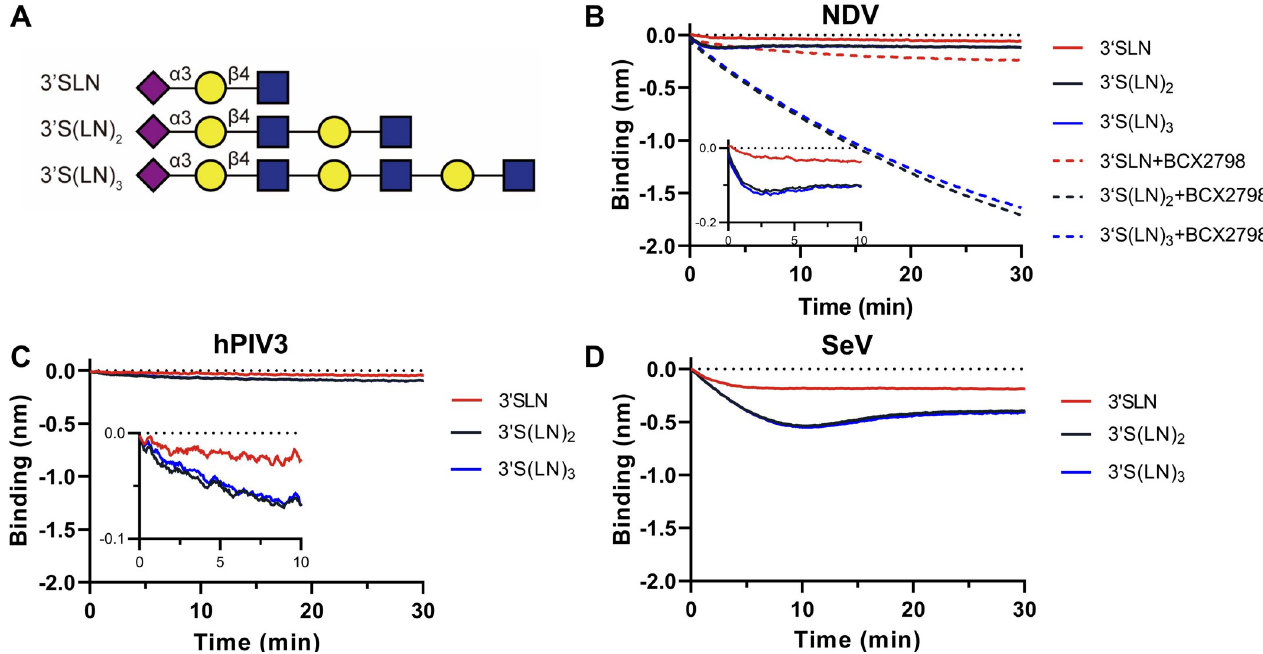
Fig 5. NDV, hPIV3, and SeV interaction with 3’SLN, 3’S(LN) 2 , or 3’S(LN) 3 . ( A) Schematic representation of biotinylated 3’SLN, 3’S(LN) 2 ,and 3’S(LN) 3 glycan structure. ( B) Analysis of NDV’s ability to bind to 3’SLN, 3’S(LN) 2 , or 3’S(LN) 3 in the presence or absence of BCX2798. Analysis of the ability of hPIV3 ( C ) and SeV ( D ) binding ability to 3’SLN, 3’S(LN) 2 , or 3’S(LN) 3 . Virus binding curves were generated similarly as described in the legend to Fig 2.